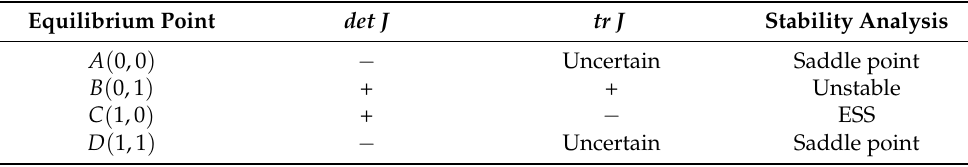
Table 6. Stable equilibrium analysis in scenario